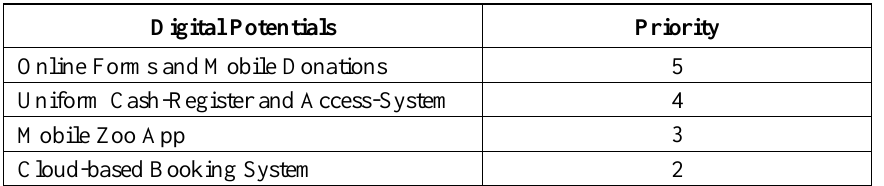
Table 4. Evaluation result of Digital Potential for zoo gardening facilities in